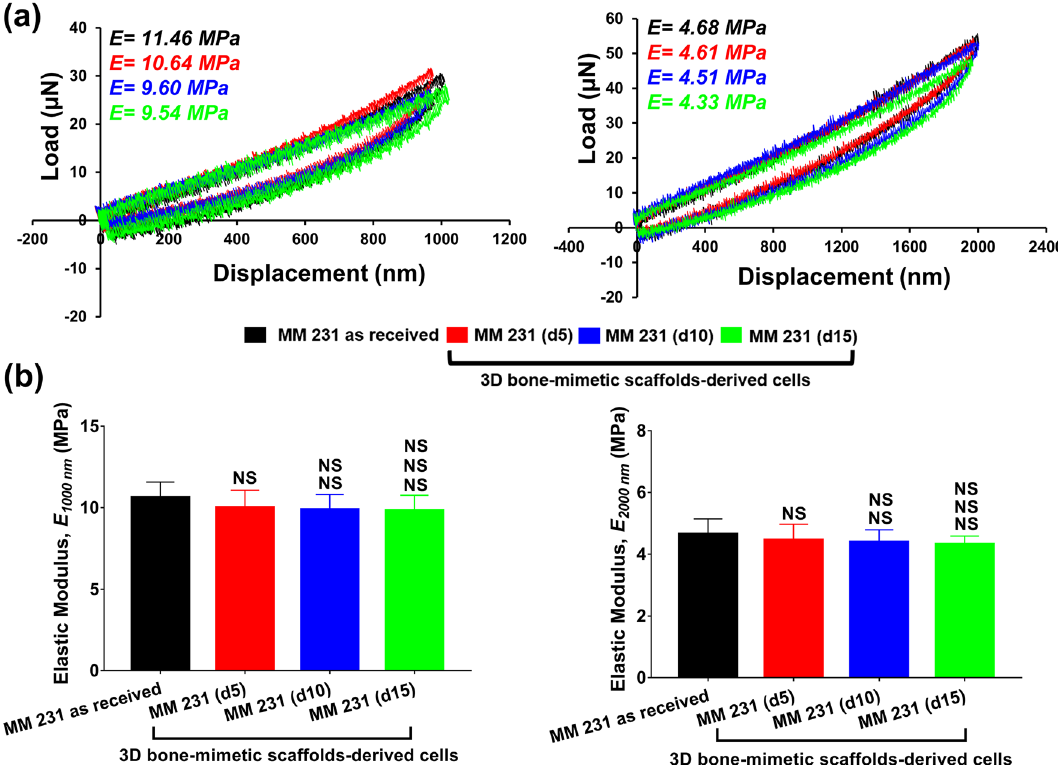
Figure 3. (a) Representative load–displacement (L-D) curves of MM 231 as received, and 3D bone-mimetic scaffolds-derived MM 231 cells at the maximum depth of 1000 nm and 2000 nm. (b) Elastic modulus of MM 231 as received and 3D bone-mimetic scaffolds-derived MM 231 cells at the maximum depth of 1000 nm and 2000 nm. For each measured sample, at least 20 cells were measured. Data are reported as a mean ± standard deviation (SD). *p < 0.05, **p < 0.01, and ***p < 0.001 indicate significant difference between MM 231 as received and 3D bone-mimetic scaffolds-derived MM 231 cells; # p < 0.05, ## p < 0.01, and ### p < 0.001 indicate significant difference between scaffolds-derived MM 231 (d5), and other scaffolds-derived cells (i.e., MM 231 (d10) and MM 231 (d15)); $ p < 0.05, $$ p < 0.01, and $$$ p < 0.001 indicate significant difference between scaffolds-derived MM 231 (d10) and MM 231